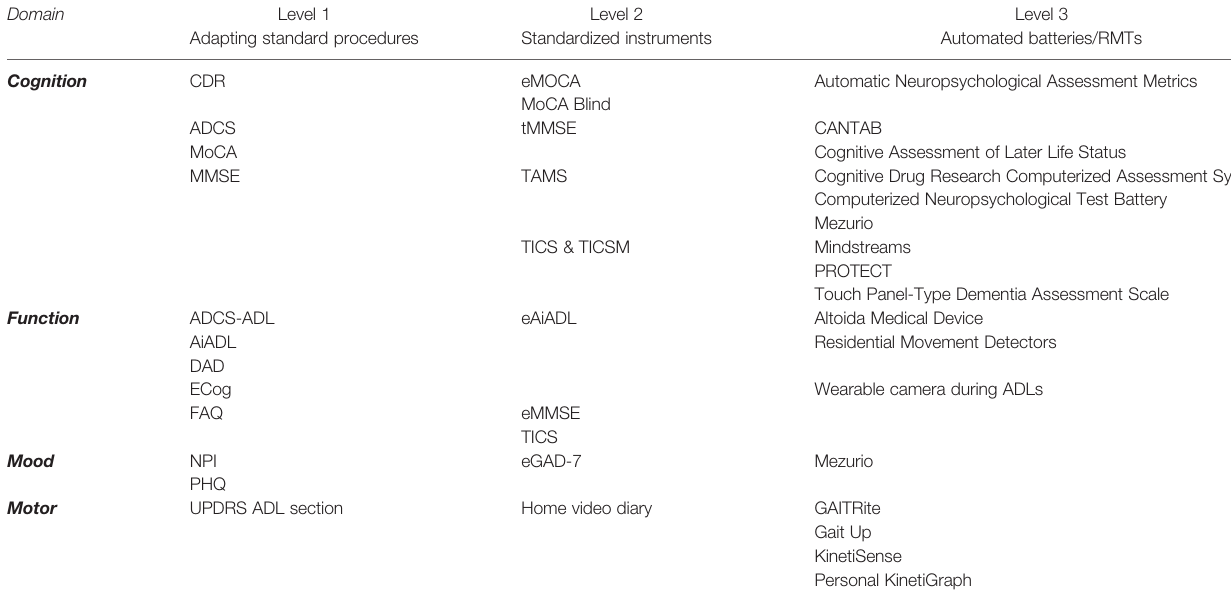
TABLE 1 | An overview of how remote memory clinics can adapt standardized procedures (level 1), use already standardized remote instruments (level 2) or utilize automated batteries and remote measurement technologies (RMT, level 3).